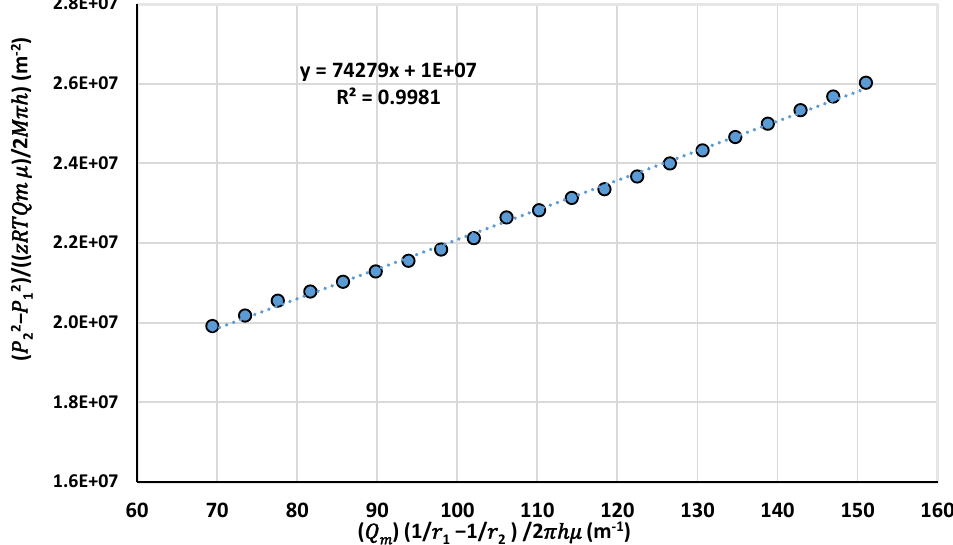
Figure 6. Calculating the non-Darcy β . Permeability = 12 Darcy .